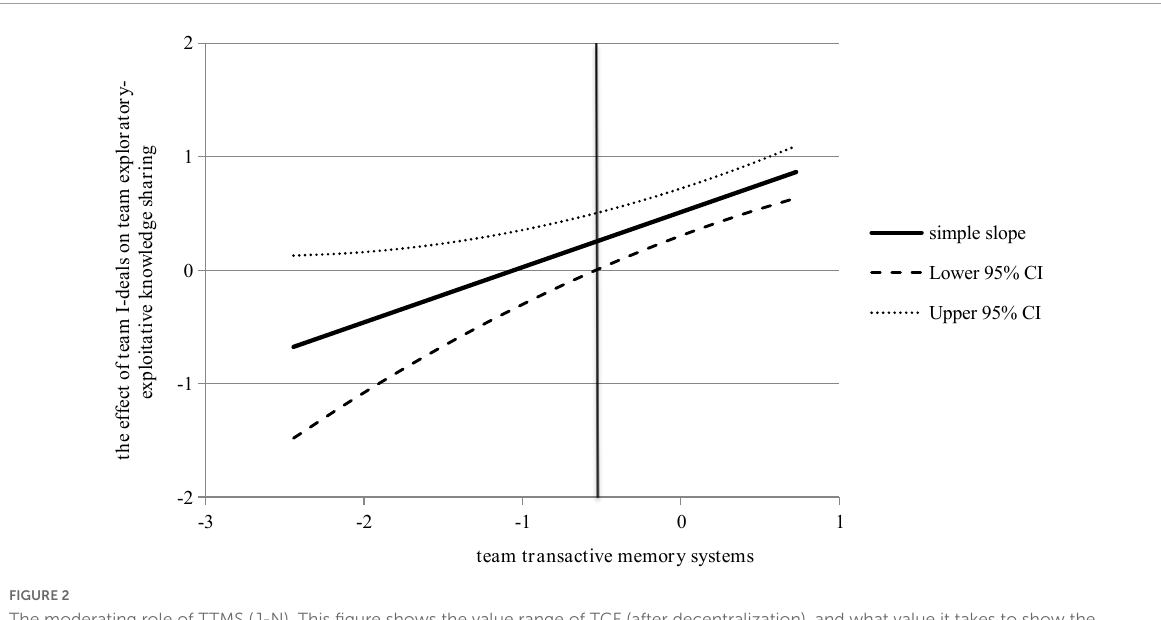
is significant ( β = 0.506, 95%CI is [0.072, 0.674]). At the same time, in the other three different combinations, because the 95% CI of indirect effects include 0, they are not